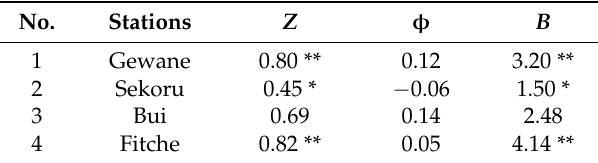
Table 4. Results of MK, innovative trend analysis method (ITAM), and Sen’s slope estimator tests for